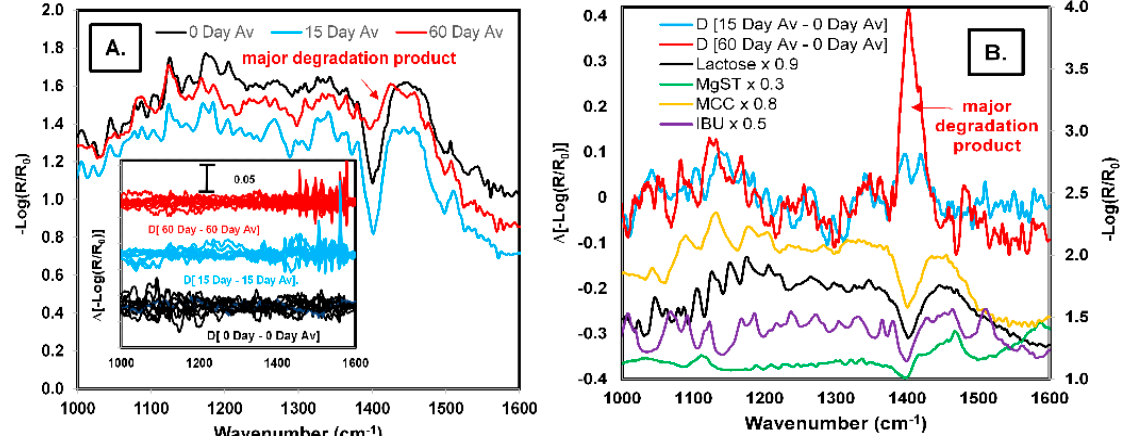
Figure 5. ( A ) Comparison between the average QCL reflectance spectra of the powder with 10% API to different times, figure inserted i (spectral subtraction between the 10 spectra of powder with 10% API in different sites and the average spectrum for each time), figure inserted (spectral subtraction between the 10 spectra of the powder with 10% API in the same site and the average spectrum). ( B ) Comparison between spectral subtraction of the spectra at other times and time zero and the components of the formulation.